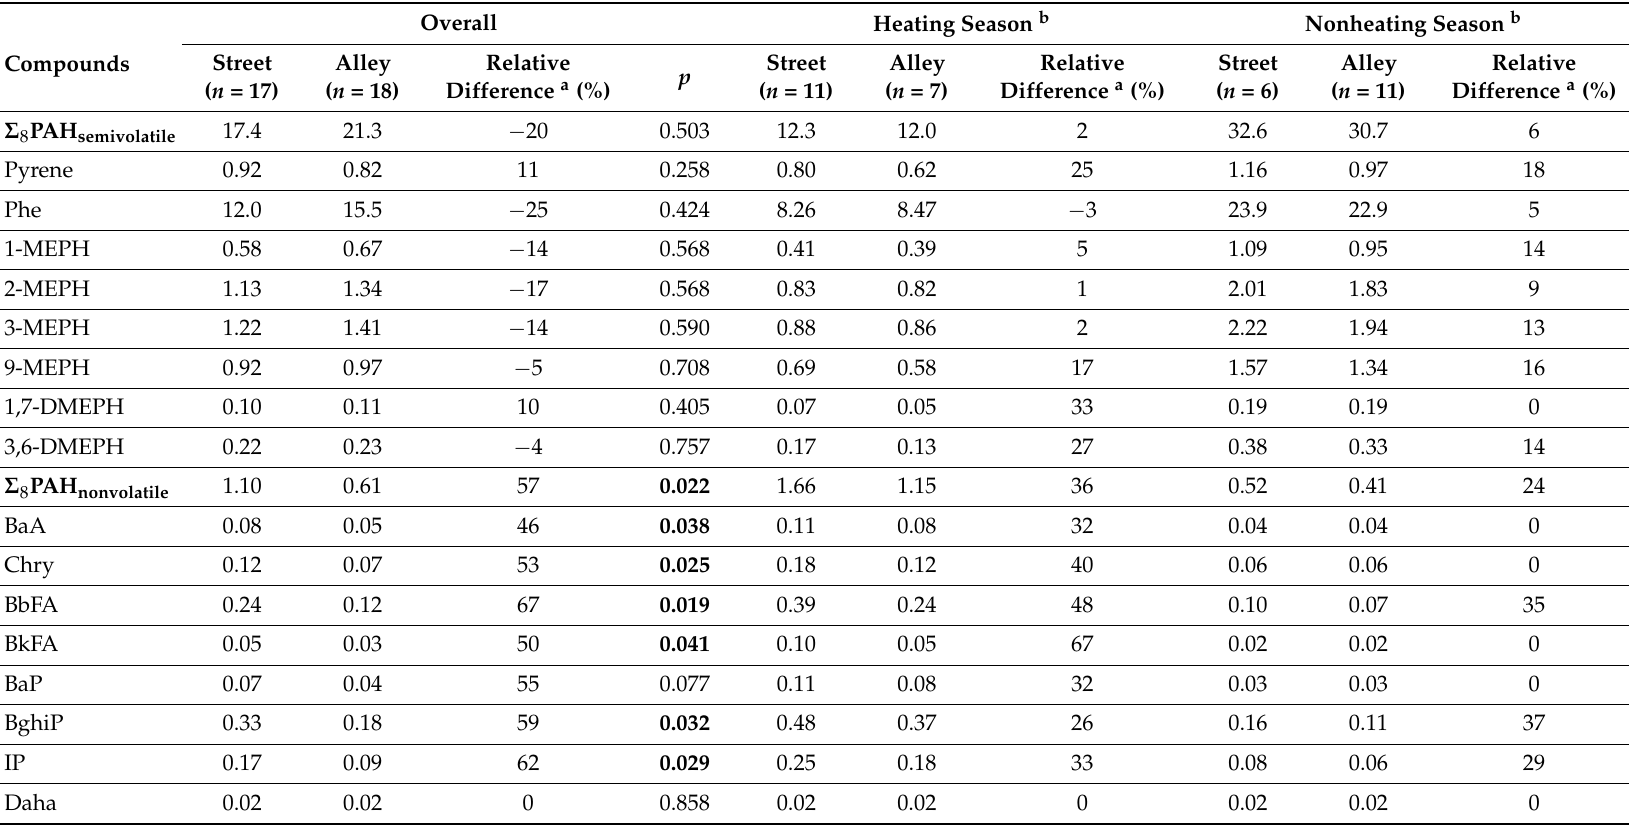
Table 3. NYC neighborhood-wide comparison of PAHs measured at street and alley sides of buildings; stratified by heating season.